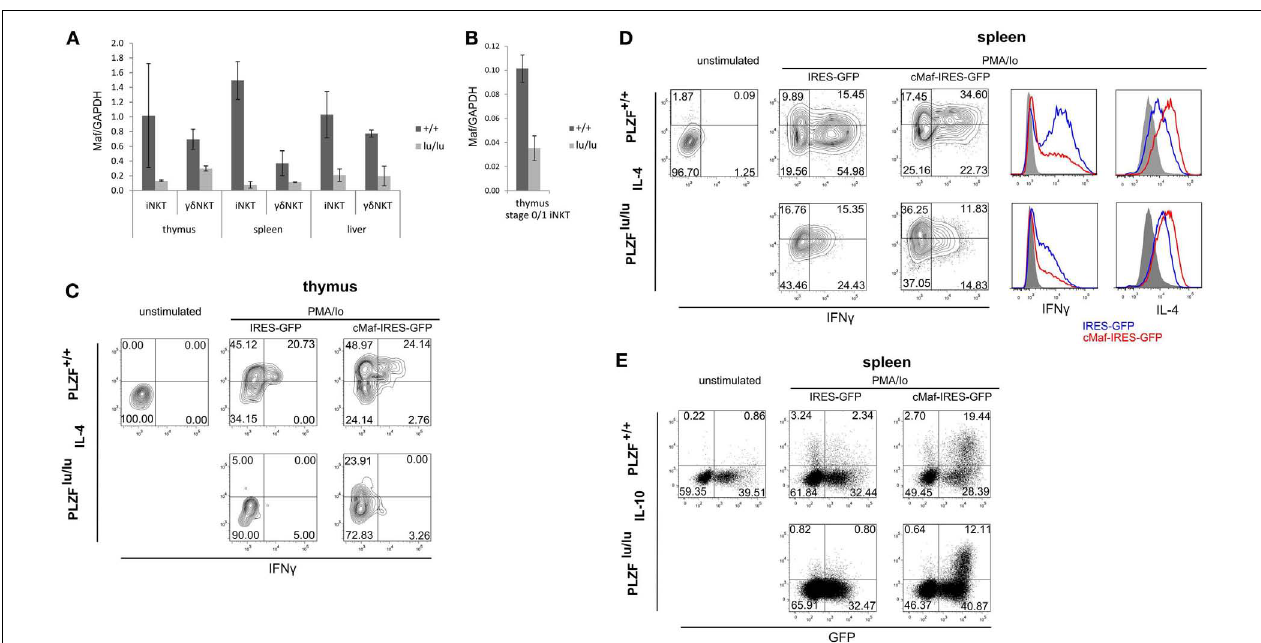
(D,E) ofWT or PLZF lu/lu mice, cultured for 2days in the presence of IL-7 and IL-15, infected with IRES-GFP or c-Maf-IRES-GFP retroviruses and stimulated with PMA/Ionomycin 2days after infection. Expression of IFN γ and IL-4 in GFP + cells (C,D) as well as IL-10 and GFP in all NKT cells (E) is shown. Representative FACS plots from one of two (C) and one of three (D,E) experiments are shown. Histogram overlays comparing cytokine production by wt and lu/lu cells in response to c-Maf expression are shown for (D)